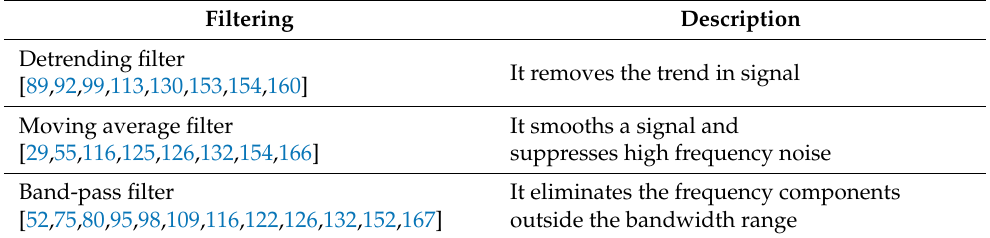
Table 4. Preprocessing using different filtering